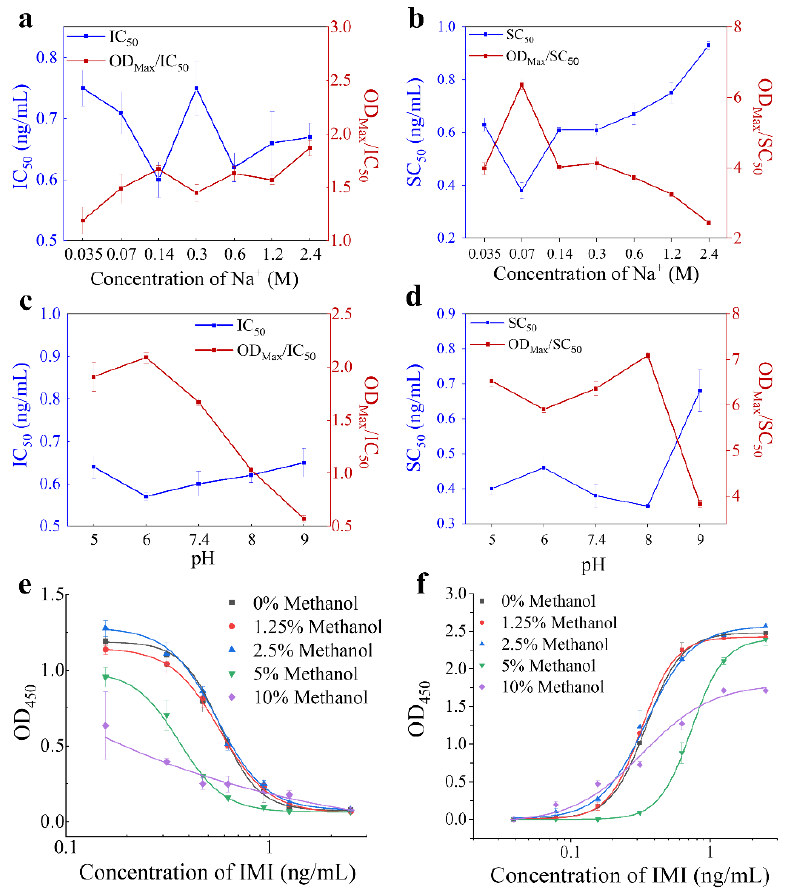
Figure 2. Optimization of P-ELISAs. ( a , c , e ) The concentration of Na + , pH and methanol for competi- tive P-ELISA. ( b , d , f ) The concentration of Na + , pH and methanol for noncompetitive P-ELISA.